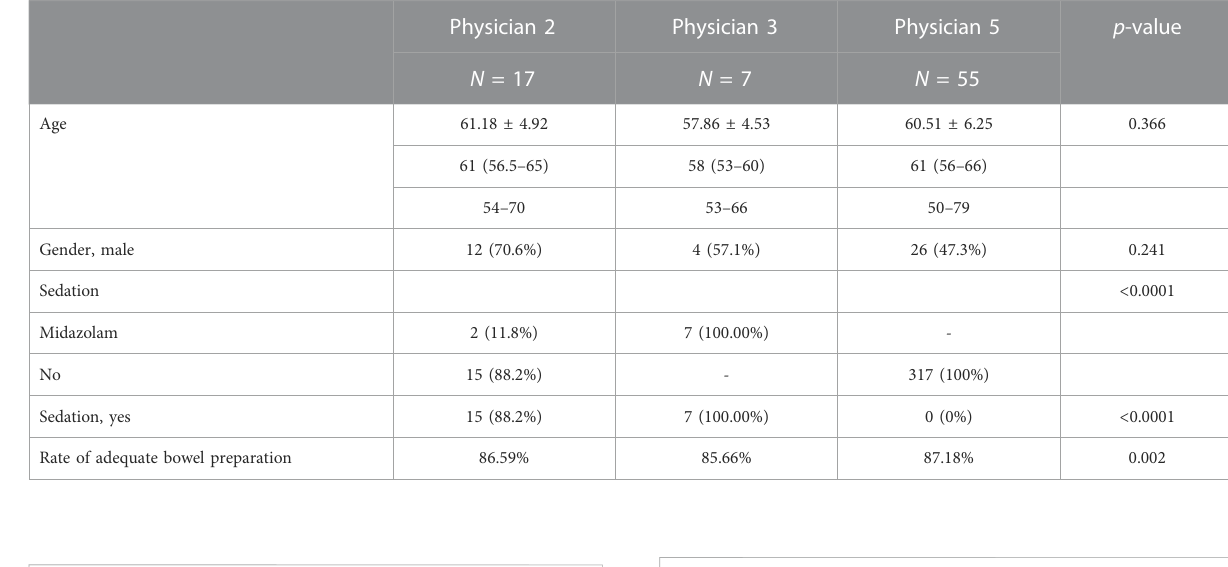
TABLE 5 Characteristics of the patients in ASGE group.